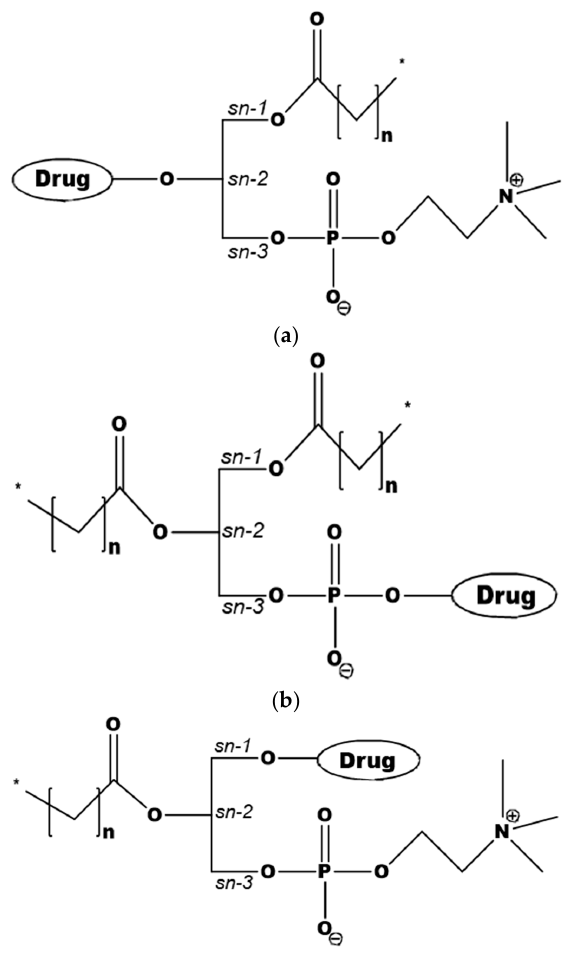
Figure 1. PL-drug conjugates, with the drug moiety attached to the sn -2 position of the glycerol backbone ( a ), to the phosphate group ( b ), or to the sn -1 position ( c ).